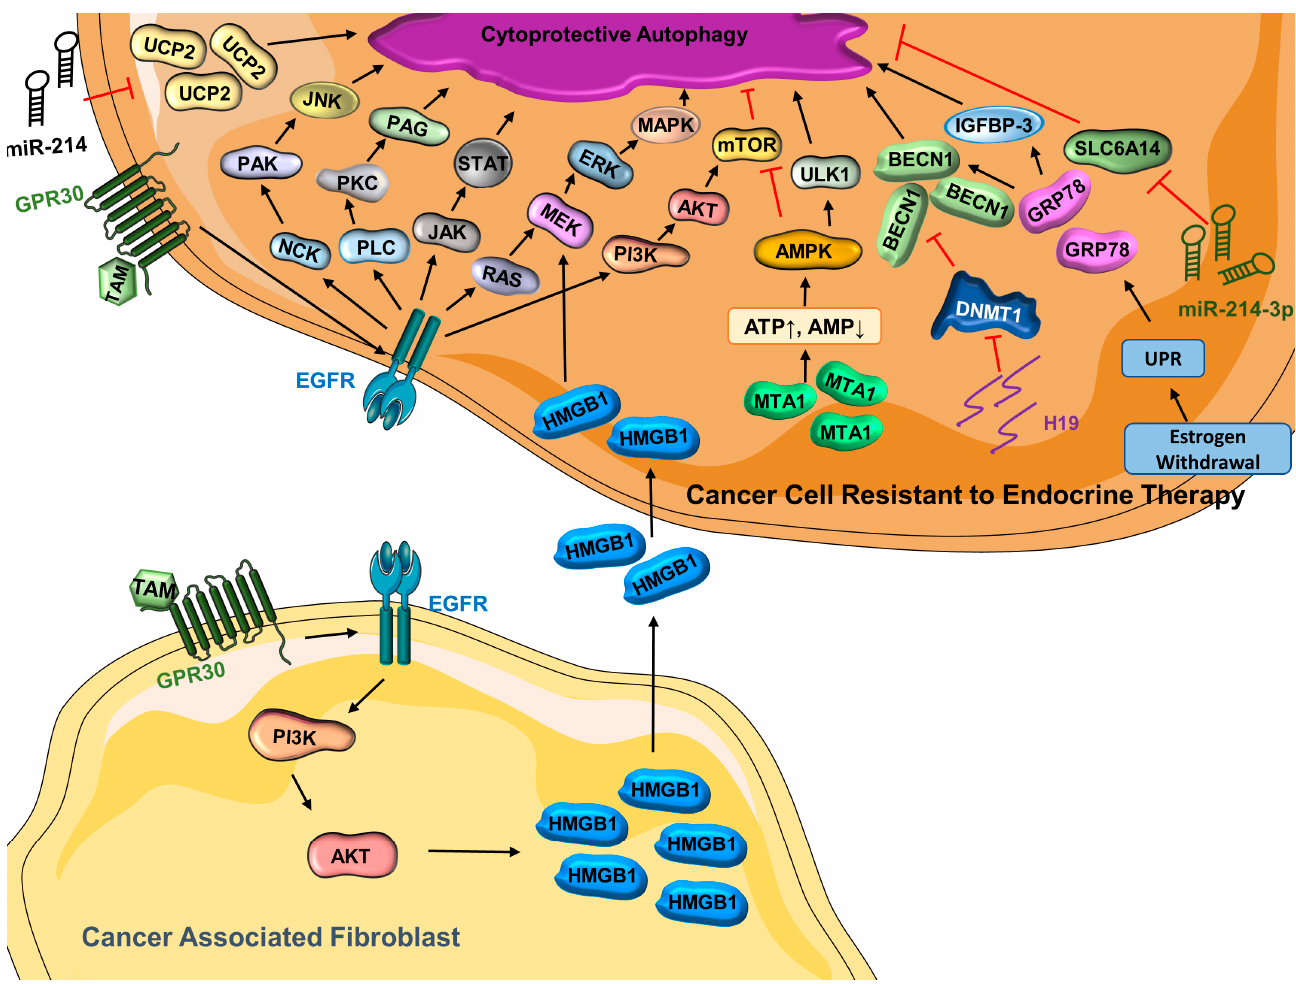
Figure 1. Cytoprotective autophagy is activated in cancer cells resistant to endocrine therapy (ATP = adenosine triphosphate; AKT = protein kinase B; AMP = adenosine monophosphate; AMPK = AMP-activated protein kinase; BECN1 = Beclin-1; DNMT1 = DNA-methyltransferase 1; EGFR = epidermal growth factor receptor; ERK = extracellular signal-regulated kinase; GRP78 = glucose-regulated protein 78; GPR30 = G protein coupled estrogen receptor; H19 = long noncoding RNA H19; HMGB1 = high mobility group box 1; IGFBP-3 = insulin-like growth fac- tor binding protein 3; JAK = Janus kinase; JNK = c-Jun N-terminal kinase; MAPK = mitogen- activated protein kinase; MEK = mitogen-activated protein kinase kinase; miR-214 = microRNA 214; miR-214-3p = microRNA 214-3p; MTA1 = metastasis-associated antigen 1; mTOR = mammalian tar- get of rapamycin; NCK = non-catalytic region of tyrosine kinase; PAG = glycosphingolipid-enriched microdomains; PAK = p-21-activated kinase; PI3K = phosphoinositide 3-kinase; PKC = protein kinase C; PLC = phosphoinositide-specific phospholipase C; SLC6A14 (solute carrier family 6 member 14); STAT = signal transducer and activators of transcription; TAM = tamoxifen; UCP2 = mitochon- drial uncoupling protein 2; ULK1 = Unc-51 like autophagy activating kinase 1; UPR = unfolded protein